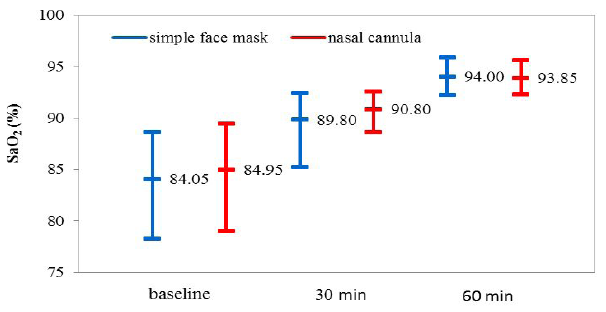
in moment 0 (baseline), and 30 minutes and 60 min- Fig. 2. SaO 2 utes after oxygen therapy by simple face mask (blue) and by nasal cannula (red). The middle points represent the value of median while the extreme points are the 25 th and 75 th percentiles Statistically significant differences were identified be- tween the clinical scores calculated dynamically after oxy- gen therapy by simple face mask: Friedman ANOVA: sta- tistics = 65.09, p < 0.001 (p-value associated to Sign test: 1.77∙10 -4 for baseline vs. 30 minutes; 1.95∙10 -9 for baseline vs. 60 minutes; 4.25∙10 -8 for 30 minutes vs. 60 minutes); nasal cannula: Friedman ANOVA: statistics = 64.58, p <